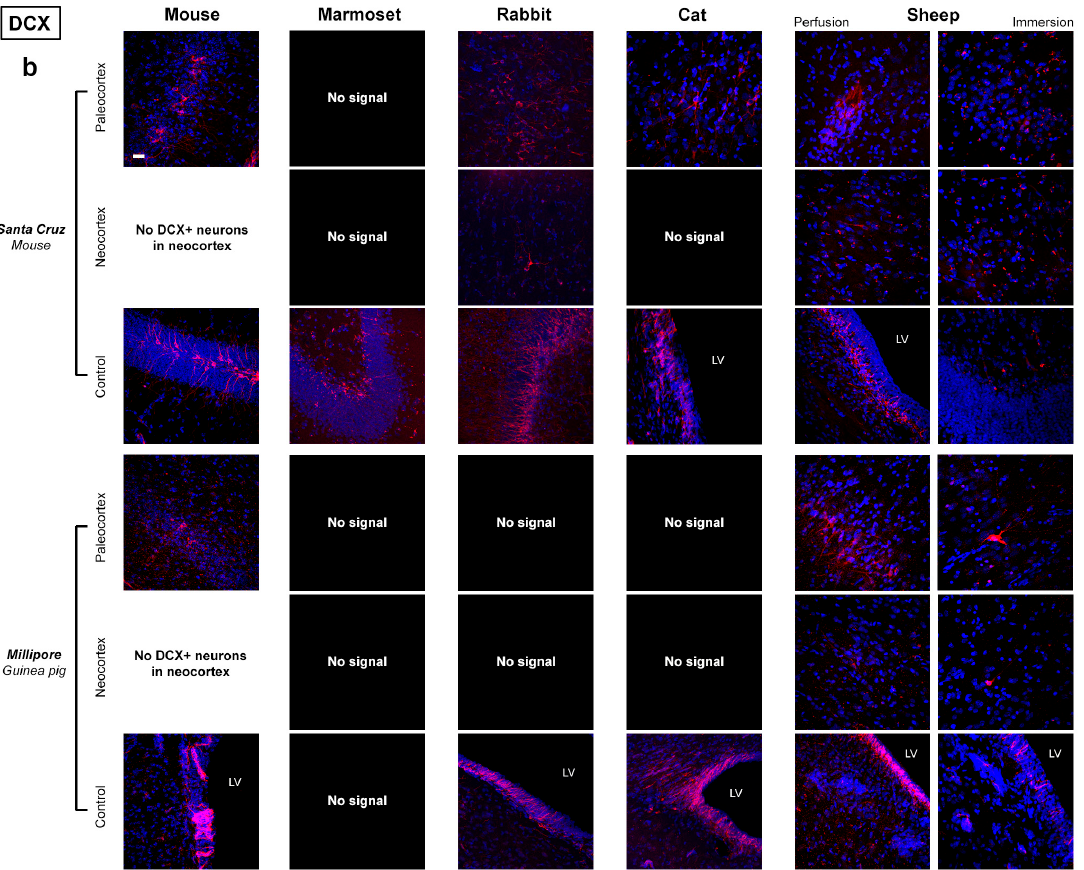
Figure 5. ( a , b ). Representative confocal images of DCX detection (in red) in different mammals for five different antibodies. All specimens are counterstained with DAPI. All photographs were taken at the same magnification (scale bar: 30 µ m). Control is represented by one of the two neurogenic sites, either SVZ or hippocampus. LV: lateral ventricle. Table 3. ( a ) Occurrence and quality of staining for DCX. ( b ) Merge (with and without citrate treatment). ( a ) Citrate Treatment (5